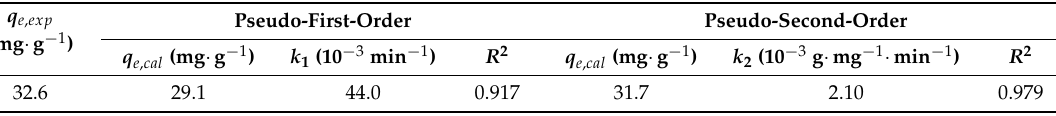
Table 3. Kinetic parameters for Cu(II) adsorption onto ICSP.